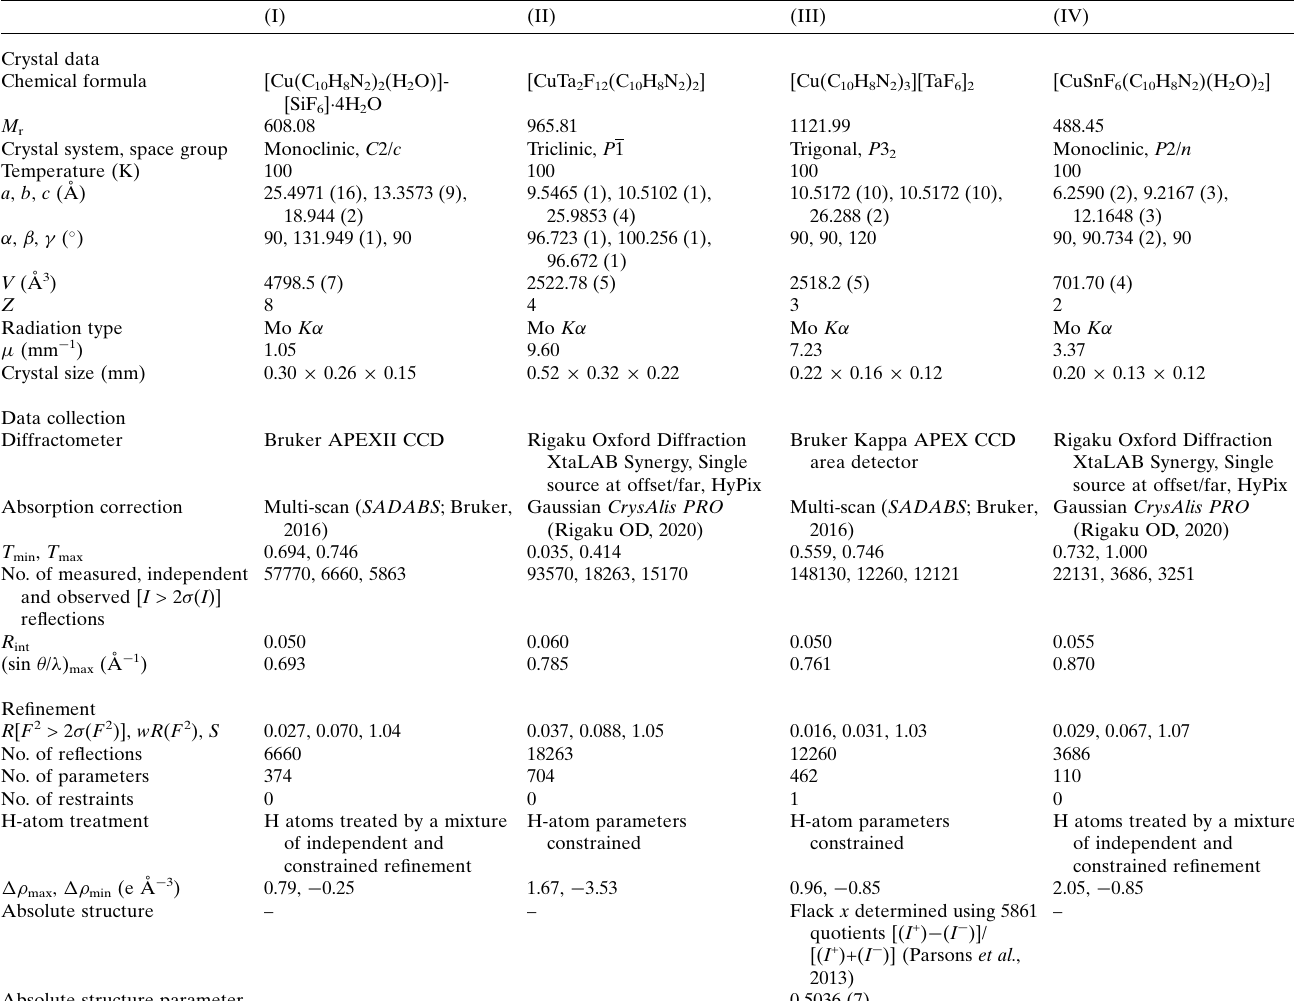
Table 3 Experimental details.